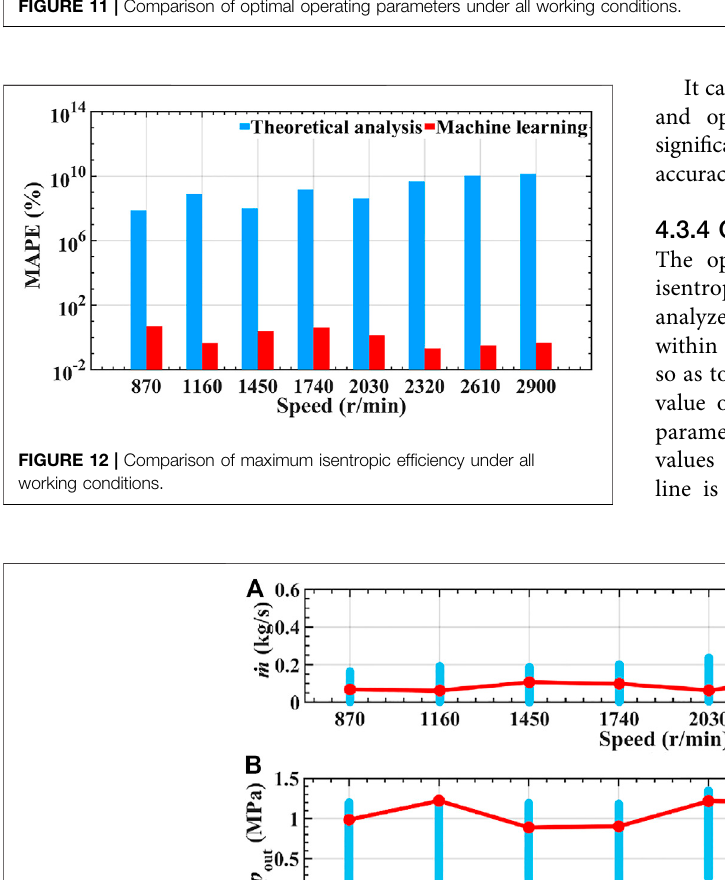
FIGURE 11 | Comparison of optimal operating parameters under all working conditions.